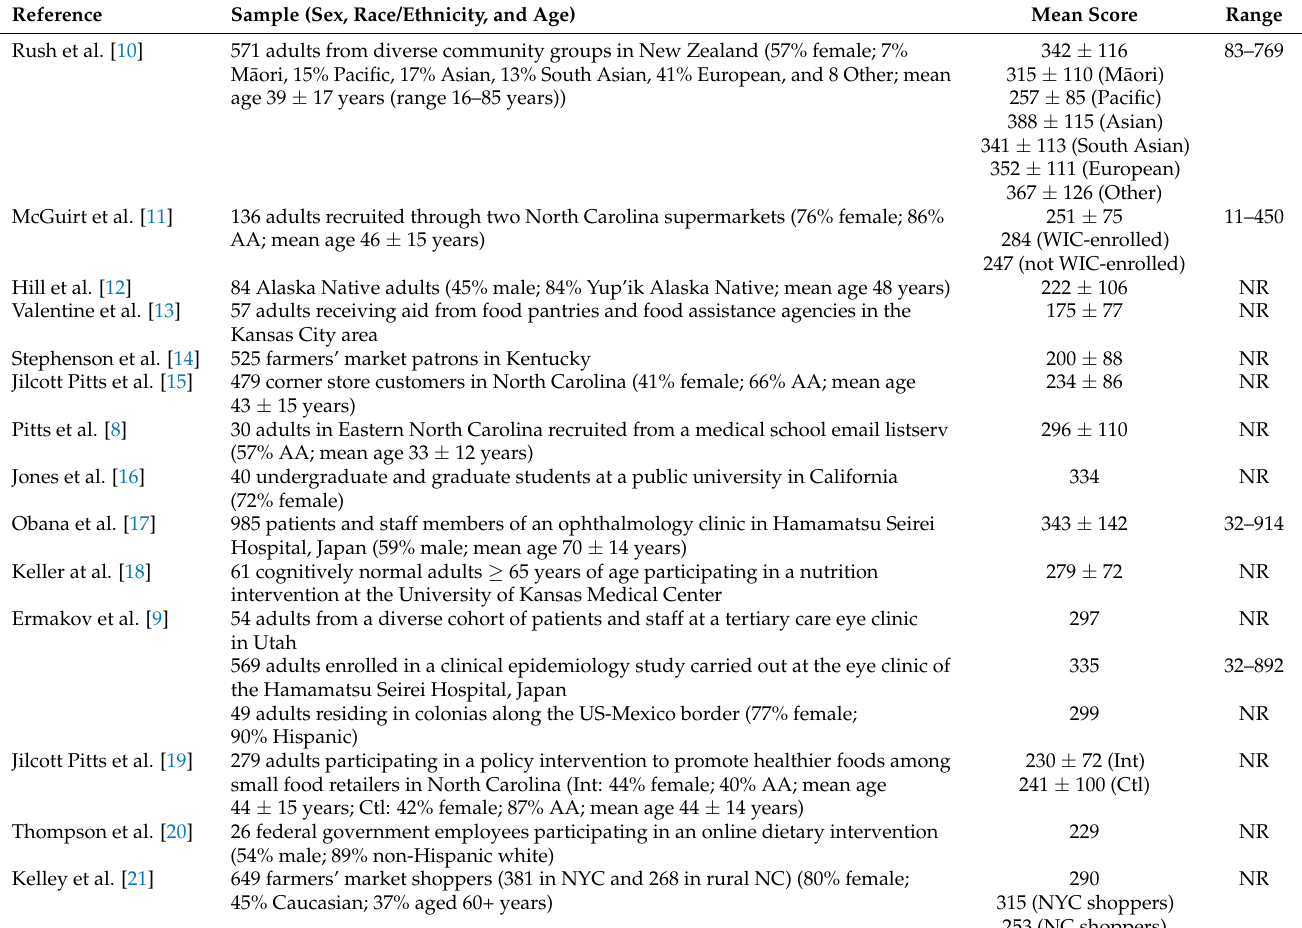
Table 1. Veggie Meter scores in adult